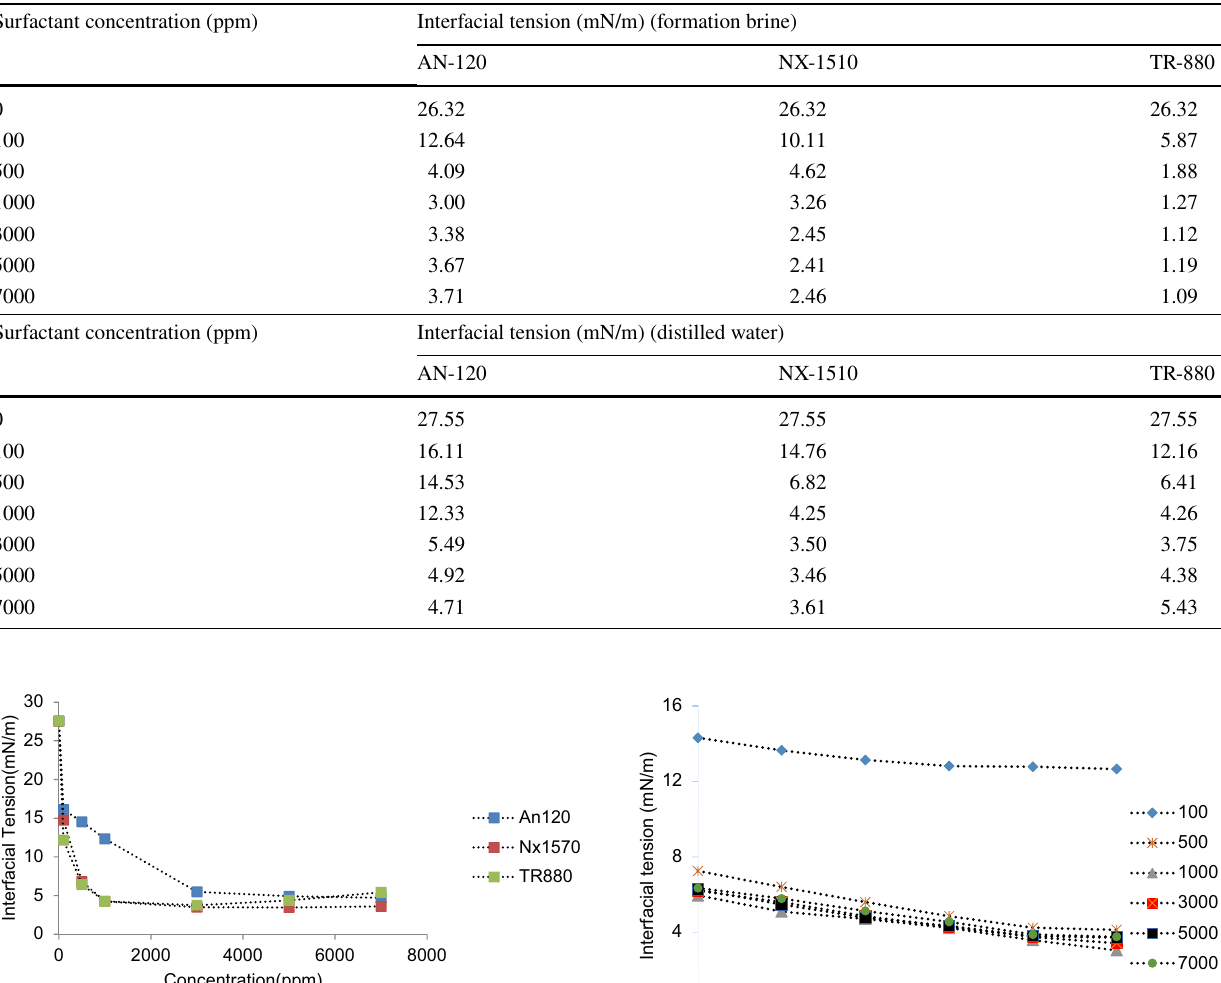
Table 4 Interfacial tension values of solutions containing AN-120, NX-1510 and TR-880 surfactants with different concentrations and crude oil at 351.15 K and 14.7 psi